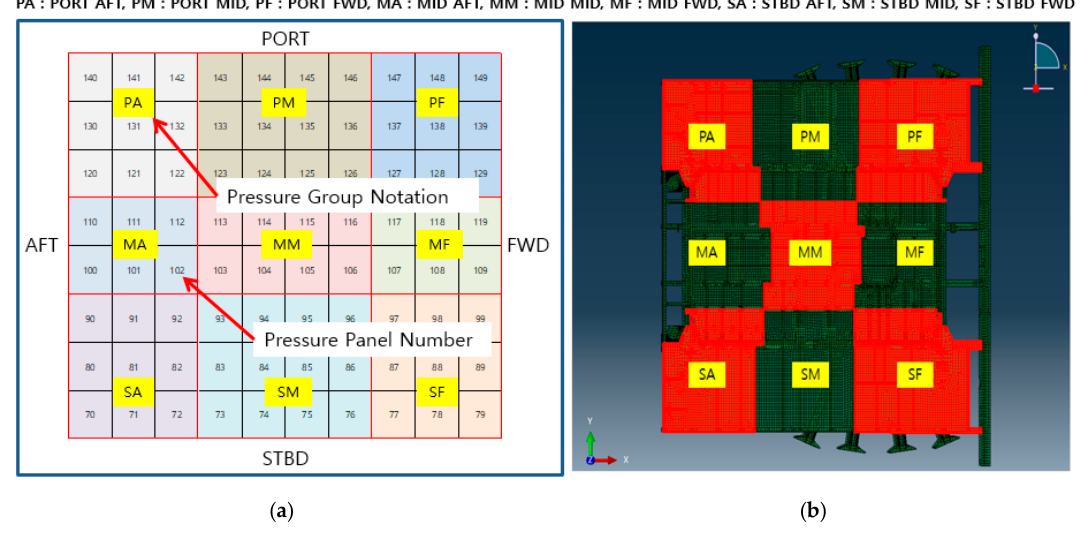
Figure 8. Flame Acceleration Simulator (FLACS) model for explosion simulation.